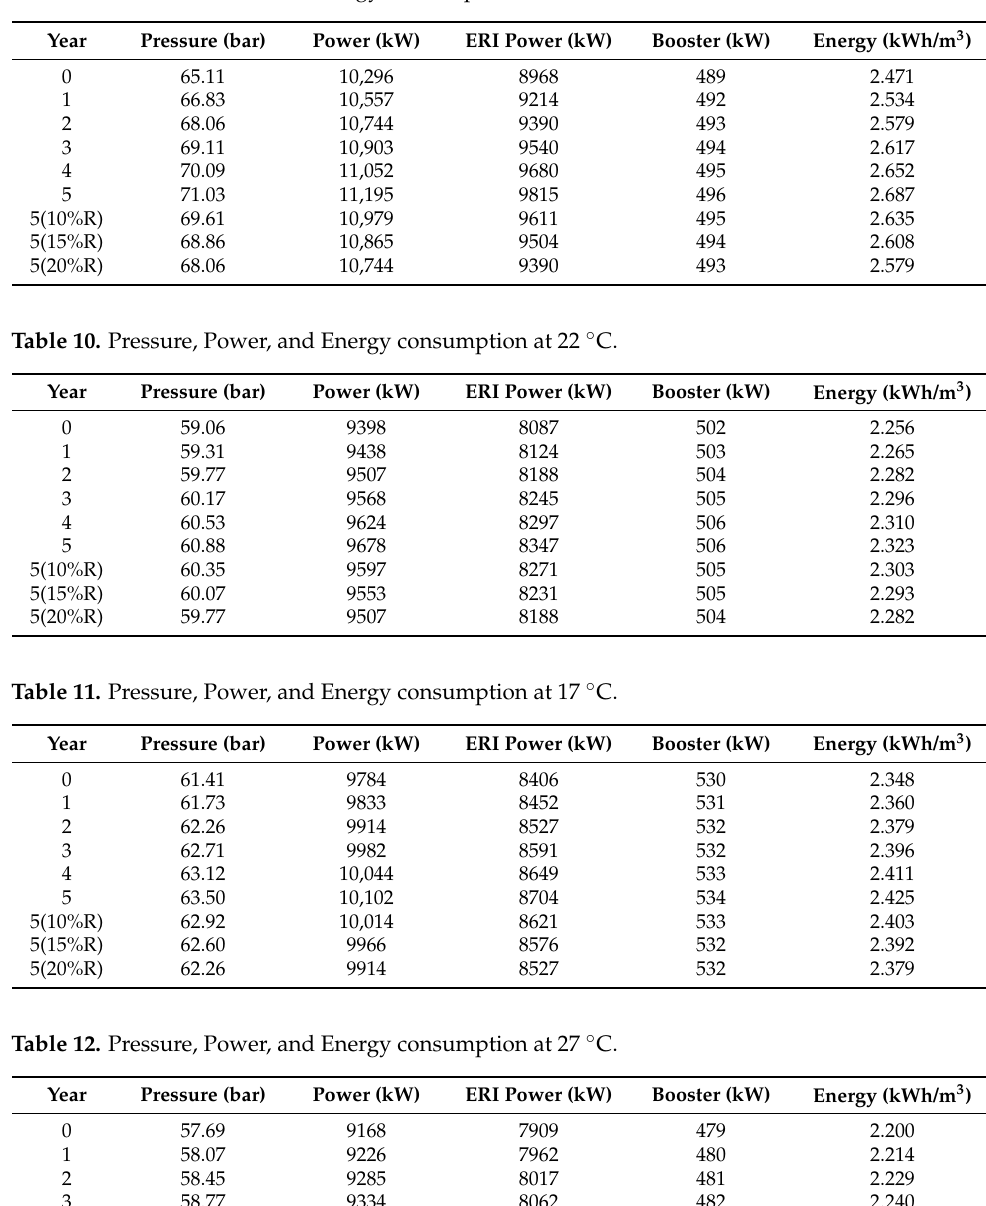
Table 9. Pressure, Power, and Energy consumption at 27 ◦ C.